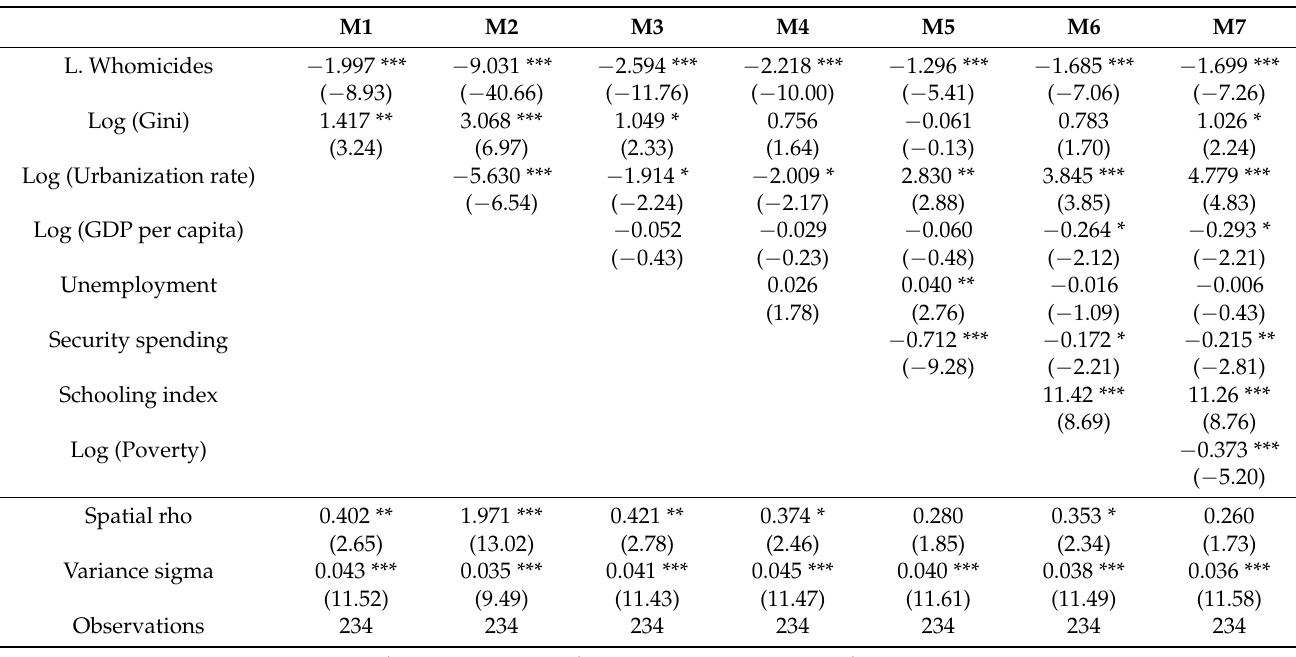
Table 12. Results of the SDM spatial model, of the relationship between inequality and the homicide rate, including the control